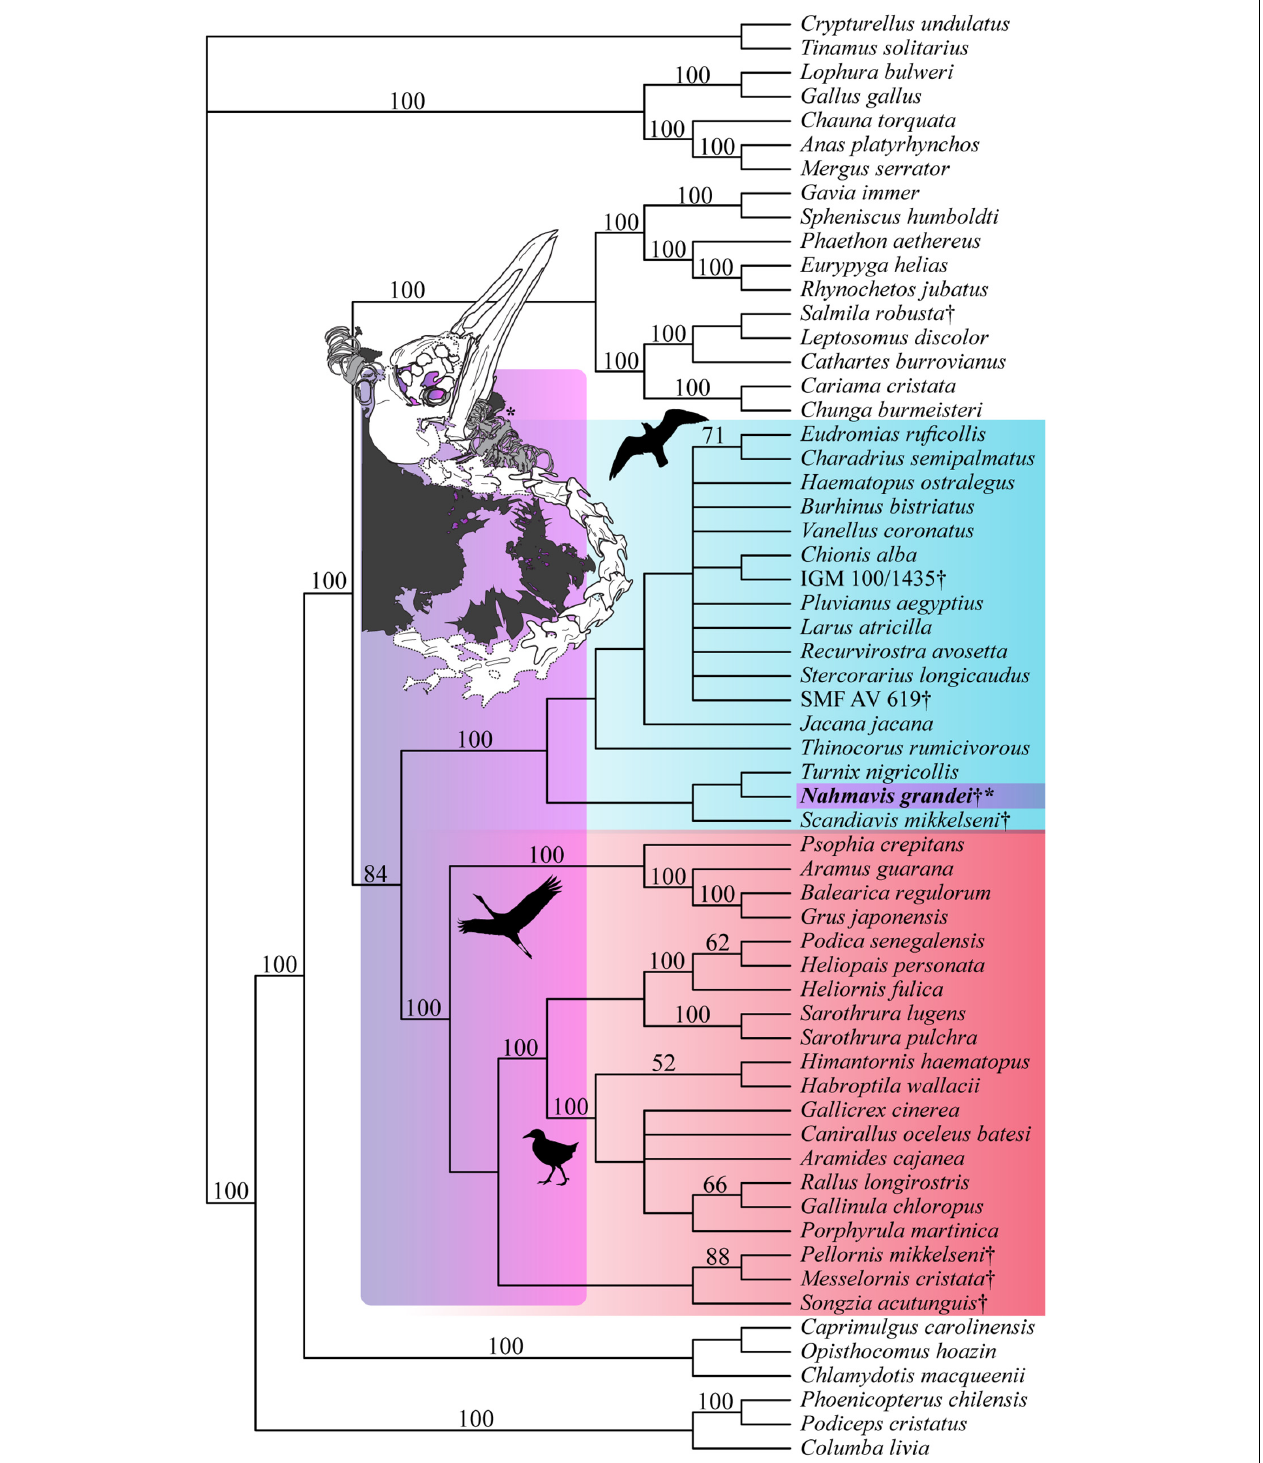
FIGURE 4 | Strict consensus tree of 56 MPTs of 5,248 steps recovered using the most recent Kimball et al. (2019) tree as a molecular backbone constraint (CI = 0.163, RI = 0.462, RC = 0.075, HI = 0.838). Charadriiform, gruoid and ralloid silhouettes are placed at the crowns of their respective clades. Charadriiformes are highlighted in blue, Gruiformes are highlighted in red, and violet spans the possible phylogenetic placements of Nahmavis grandei across these clades. All extinct taxa are denoted with daggers. Bootstrap support values greater than 50% are denoted above branches.